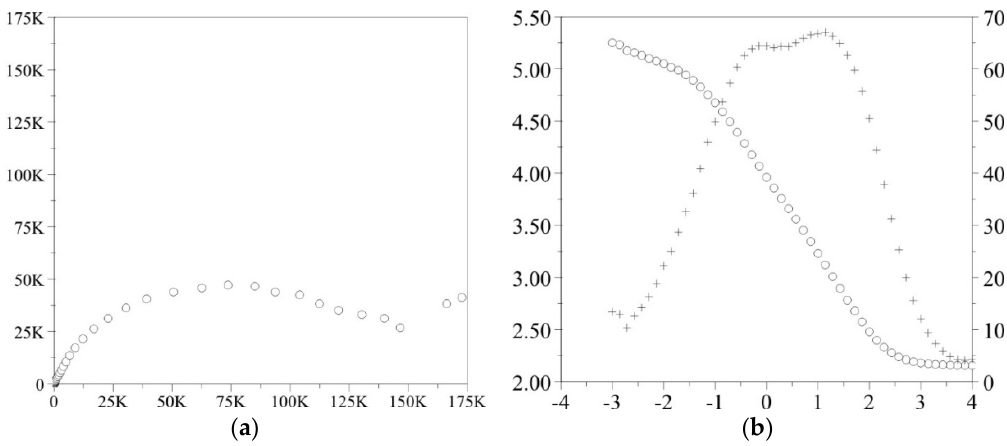
Figure 5. Impedance spectra determined for the initial state ( a ) Nyquist diagram, ( b ) Bode diagram.